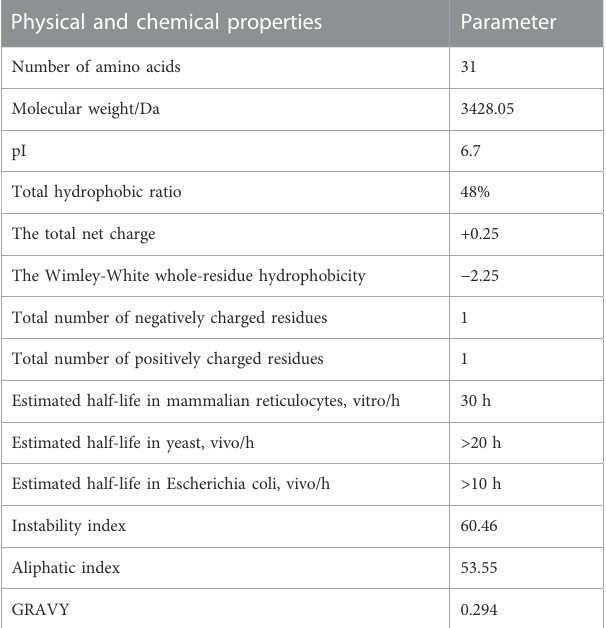
TABLE 1 Physicochemical properties of JZTX-14. Predicted by